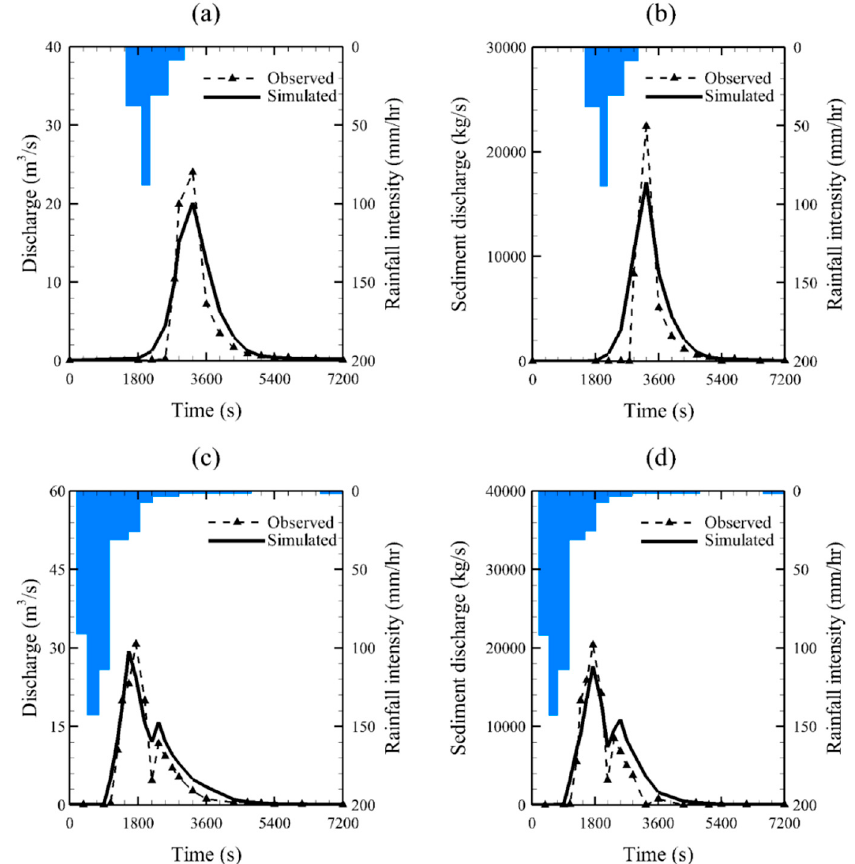
Figure 4. Hydrographs and sedigraphs of the model calibration (( a ) and ( b ), event of 14 July 1964) and validation (( c ) and ( d ), event of 2 August 1964). Note that the blue bars represent the rainfall intensity.